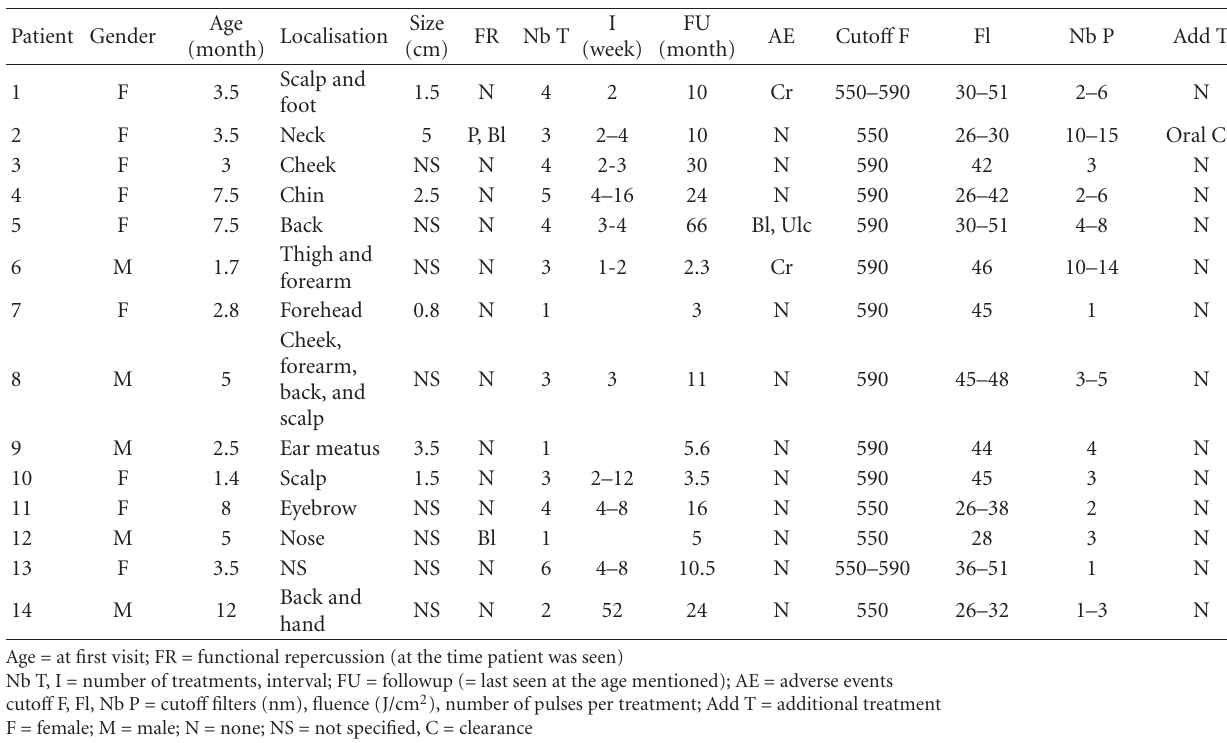
Table 1: Salient clinical characteristics of the 14 infants.